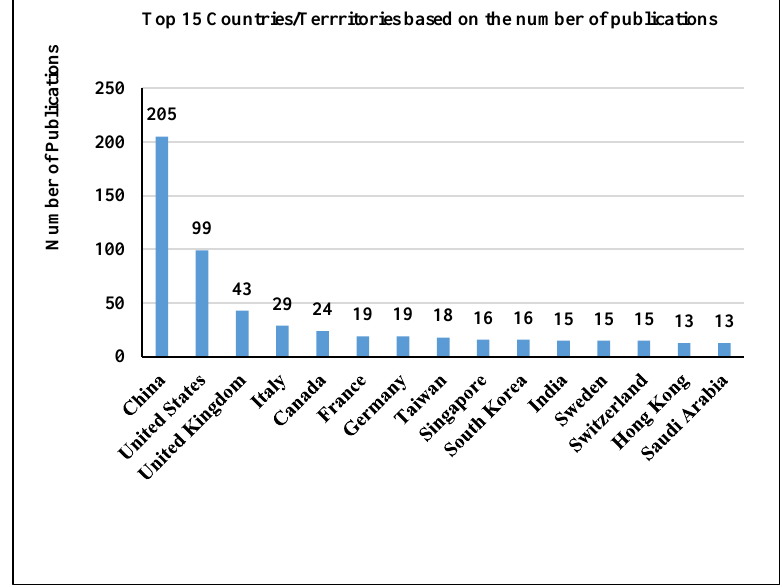
Figure 1. Contributing countries/territories in the field of COVID-19